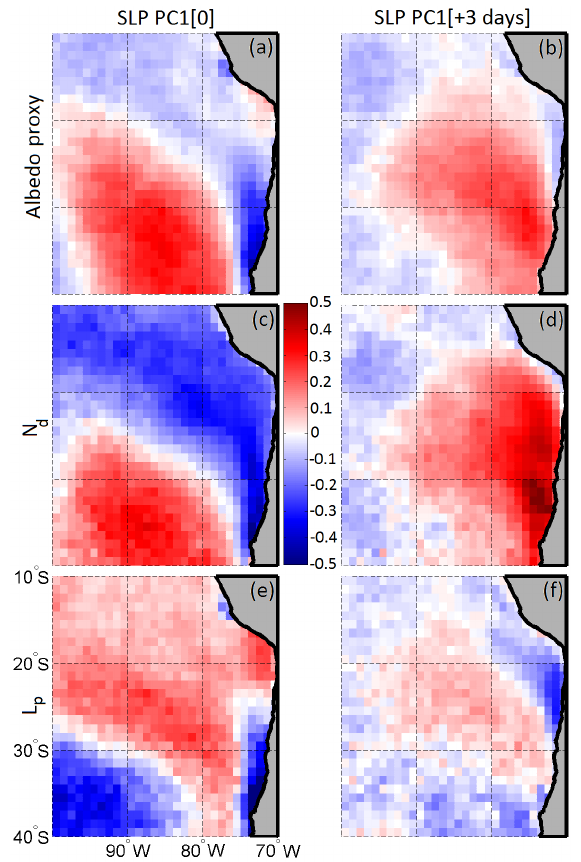
Fig. 7. Fractional composite differences on (a) , (c) , (e) SLP PC1[0] and (b) , (d) , (f) SLP PC1[+3], 3 days after strong values in SLP PC1. Composites are generated as described in Sect. 4.2.1.